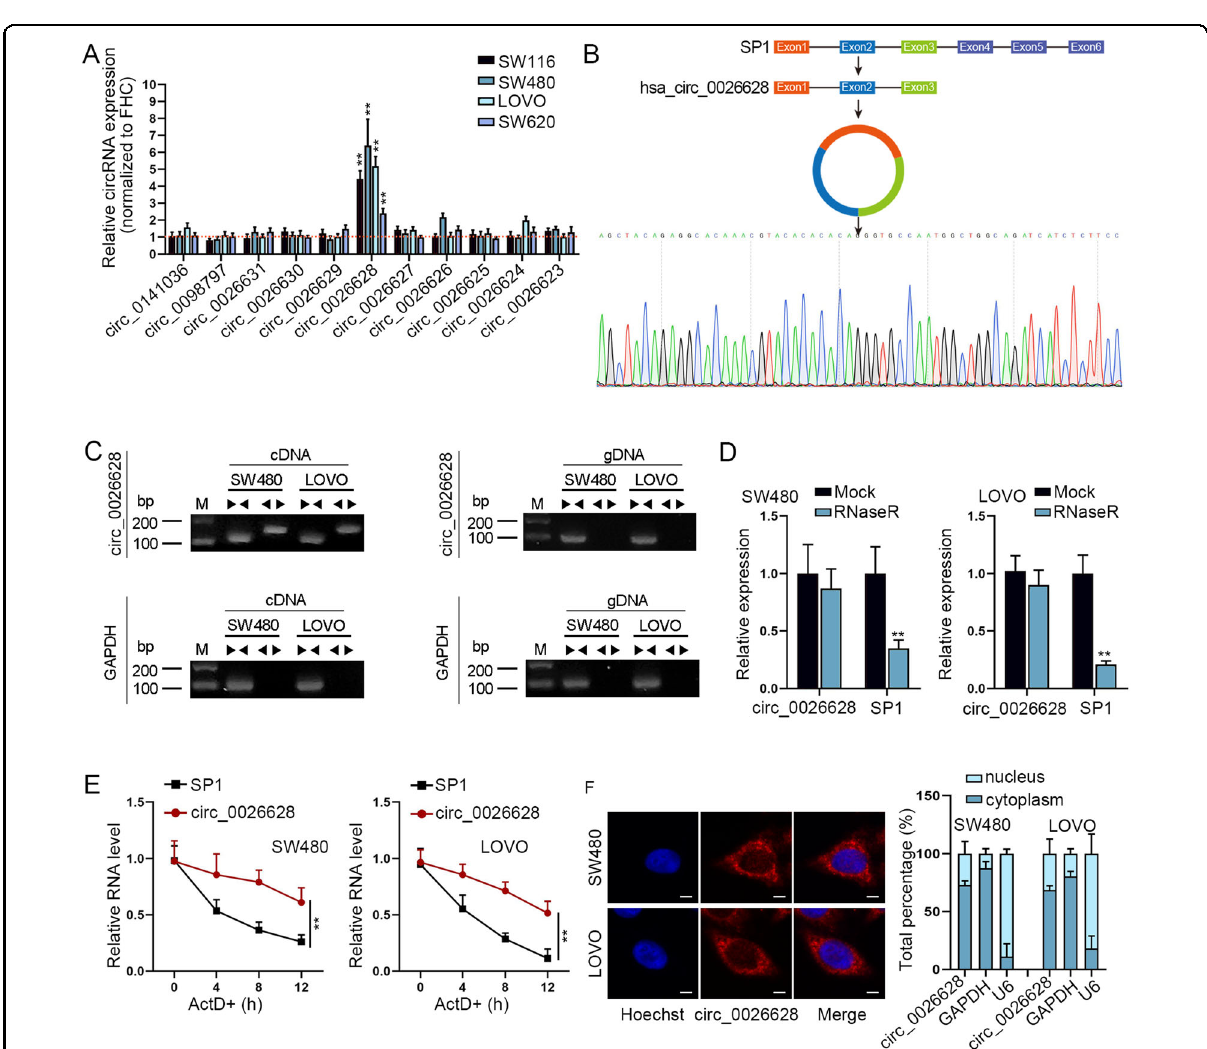
Fig. 1 Circ_0026628 was upregulated in CRC cells. A qRT-PCR measured the expression pro fi le of 11 SP1-derived circRNAs in CRC cells relative to the control FHC cells. One-way ANOVA. B The schematic diagram of the genomic position of circ_0026628 and the Sanger sequencing results for the splicing junction of circ_0026628. C Agarose gel electrophoresis validated the existence of circ_0026628 in CRC cells. D , E qRT-PCR measured the relative level of circ_0026628 and linear SP1 in CRC cells under the treatment of RNase R or ActD. Student ’ s t -test or two-way ANOVA. F FISH (scale bar: 20 μ m) and subcellular fraction assays revealed the subcellular location of circ_0026628 in SW480 and LOVO cells. ** P <